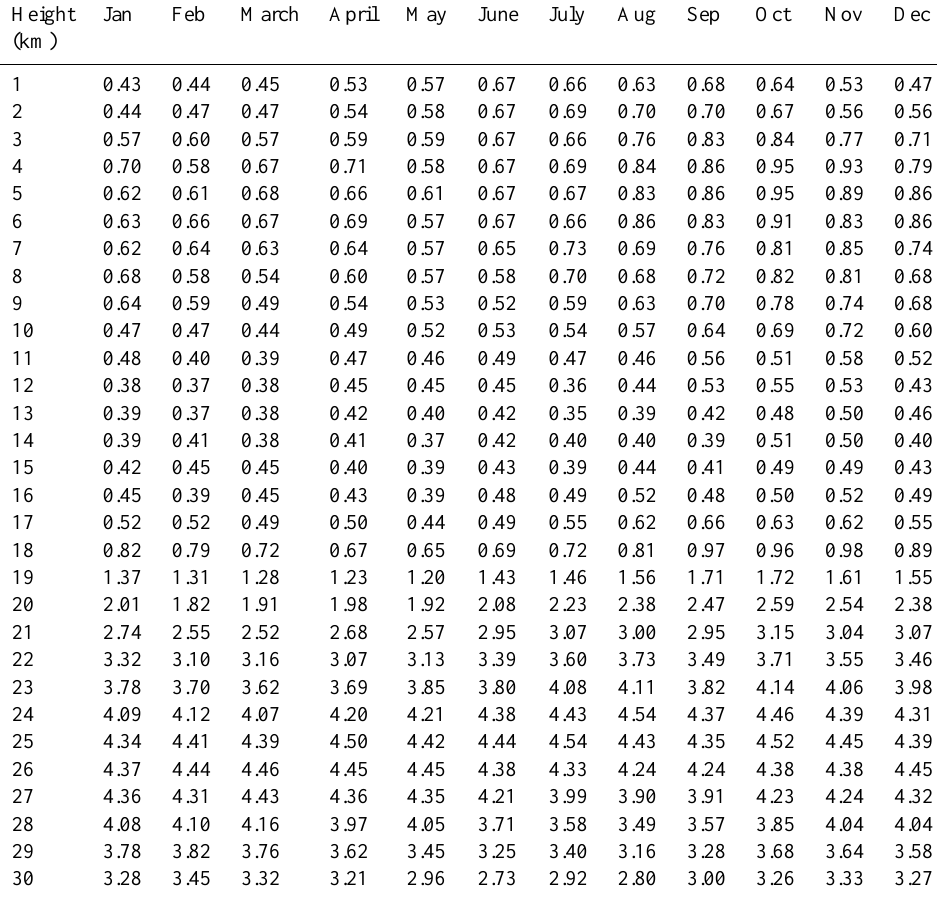
Table A1. Monthly mean ( × 10 12 mol/cm 3